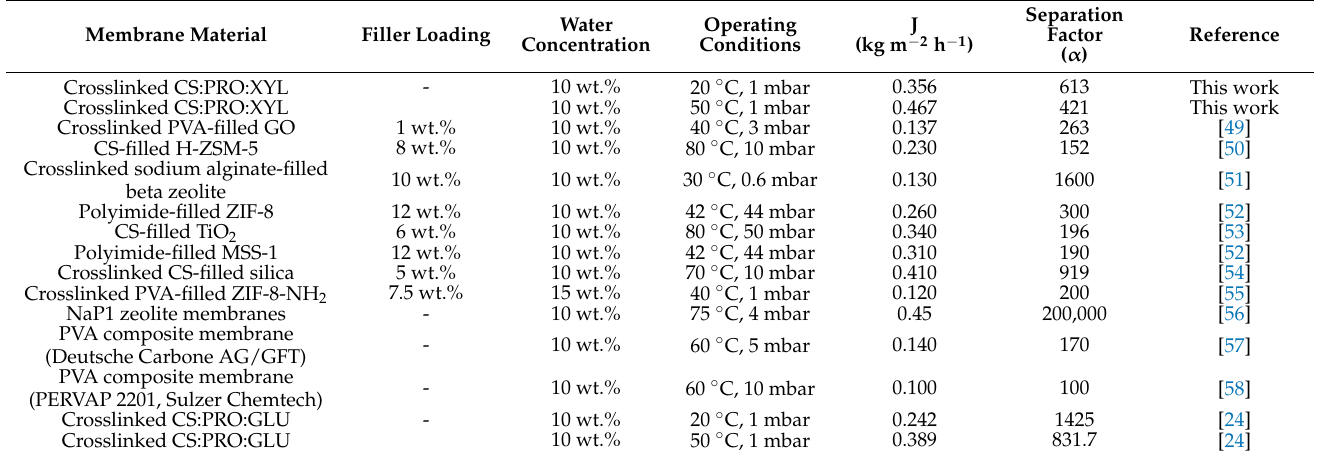
Table 4. Pervaporation separation of various polymer blends and composite membranes for ethanol dehydration and their comparison with crosslinked CS: PRO: XYL membrane